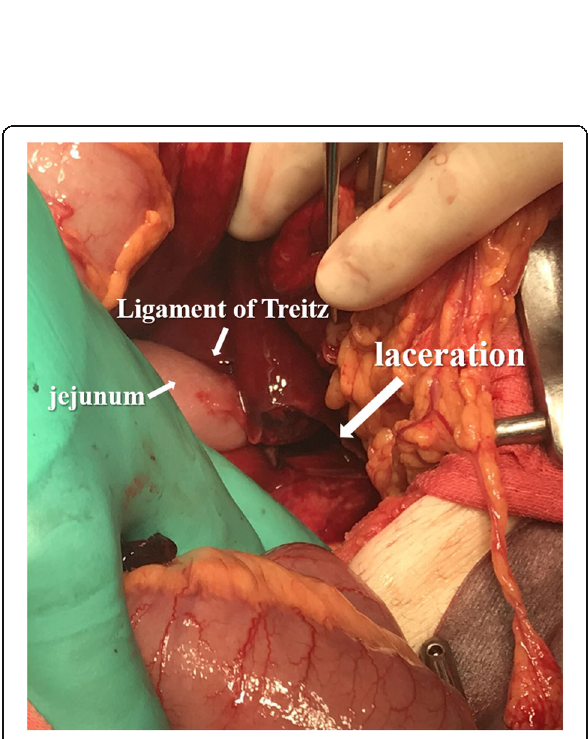
Fig. 3 An intraoperative finding of an emergency laparotomy is shown. After removal of a fist-sized hematoma and a large amount of intraabdominal hemorrhage, approximately 5 cm in length of a mesenteric laceration in the transverse colon adjacent to the left side of Treitz ’ s ligament was revealed. Hemostasis was achieved by suture ligations but repair of the laceration was impossible because the tissue was too